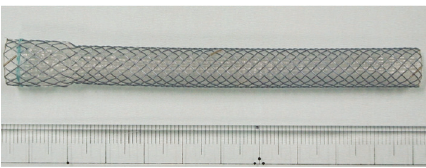
Figure 2: Fully covered Niti-S ultrathin stent (Taewoong Medical) 10 cm long with diameters of 12mm (proximal) and 10mm